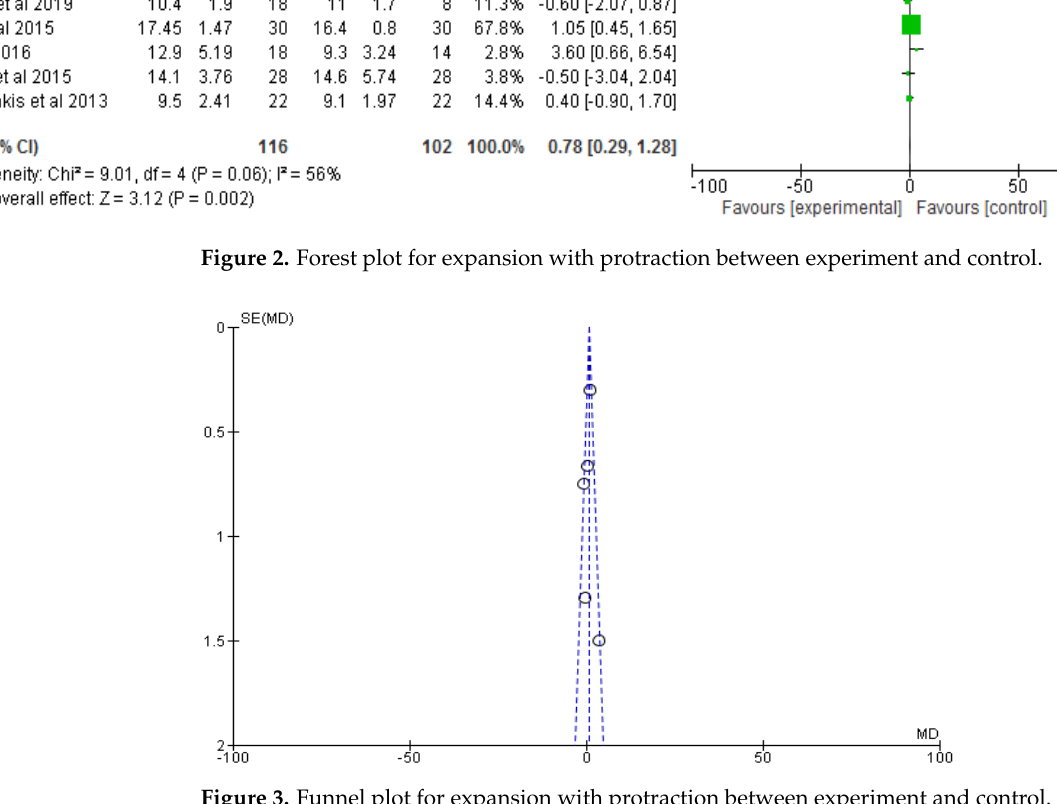
Figure 3. Funnel plot for expansion with protraction between experiment and control.